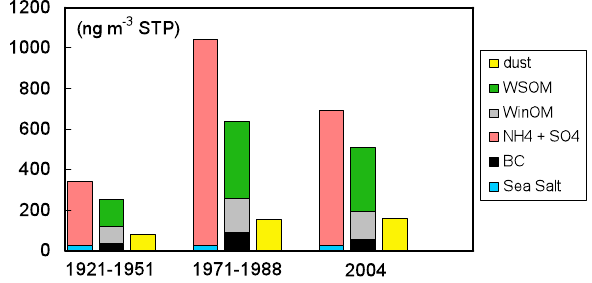
Fig. 11. Temporal changes of summer mass concentrations of dif- ferent aerosols at the CDD site. For the 1921–1951 and 1971–1988 years, atmospheric concentrations were estimated by inverting ice concentrations (see Sect. 6), whereas the 2004 concentrations are data gained during a field atmospheric campaign conducted in sum- mer 2004 (Legrand et al. 2007b; Preunkert et al., 2007).